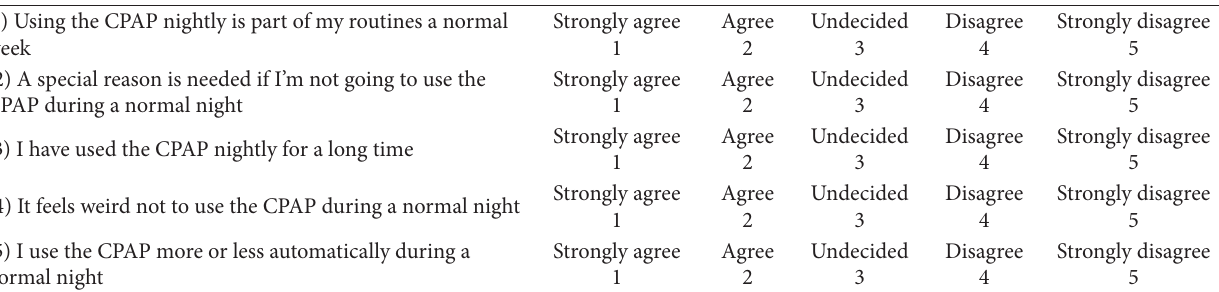
Table 1: A description of the CPAP Habit